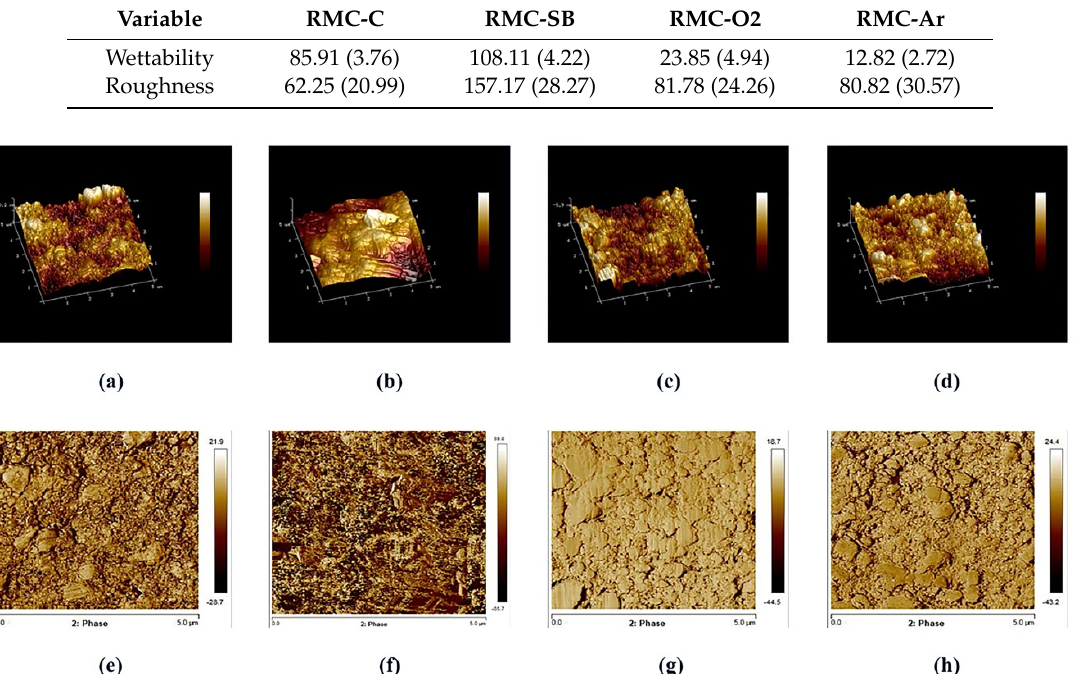
Table 5. Mean and standard deviation (SD) values of wettability (degree) and roughness (Ra, nm) in the RMC group.